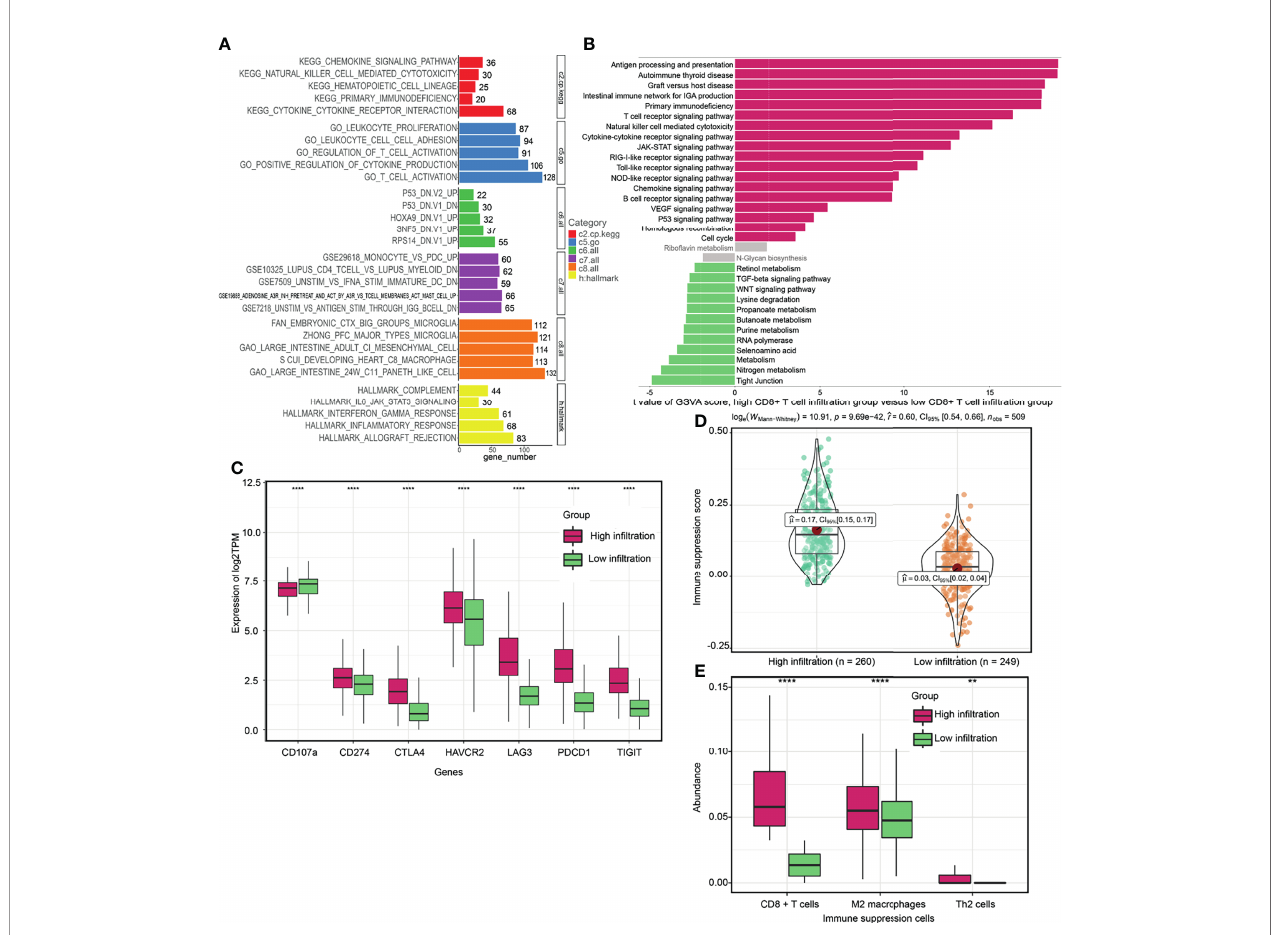
FIGURE 2 | Potential biological functions of CD8 + T cells. (A) Comprehensive functional enrichment analysis of CD8 + T cell related genes. (B) Gene set variation analysis (GSVA) between high CD8 + T cell- in fi ltration and low CD8 + T cell- in fi ltration groups. (C, D) Differences of immune-related signatures between high CD8 + T cell- in fi ltration and low CD8 + T cell- in fi ltration groups. (E) The abundance of each immunosuppressive cell in high CD8 + T cell- in fi ltration and low CD8 + T cell- in fi ltration groups. (**** P < 0.0001; ** P <